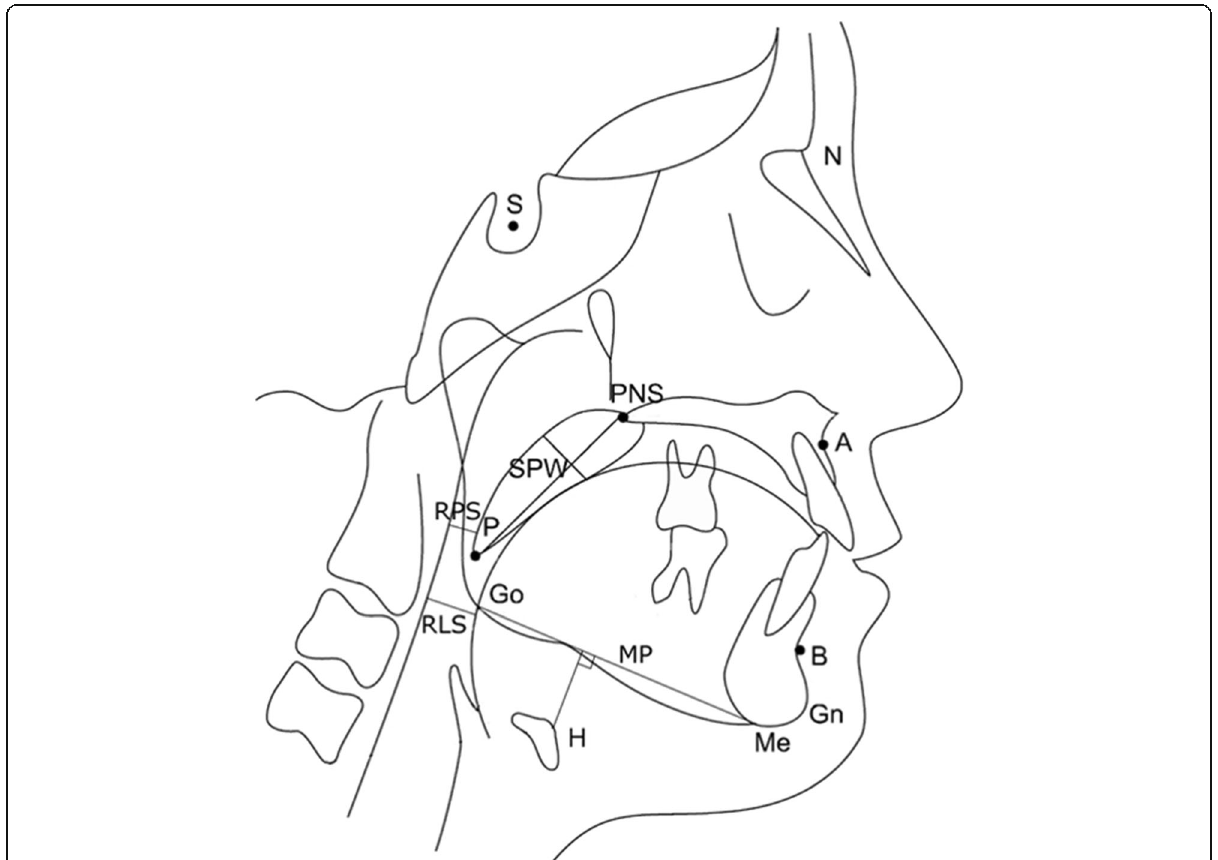
Fig. 1 Linear and angular measurements for bony and soft tissue framework in lateral cephalometry. S (sella), midpoint of the fossa hypophysealis; N (nasion), anterior point at the frontonasal suture; A, the deepest anterior point in the concavity of the anterior maxilla; B, the deepest anterior point in the concavity of the anterior mandible; PNS (posterior nasal spine), the most posterior point on the nasal spine; Go (gonion), a mid-point at the gonial angle located by bisecting the posterior and inferior borders of the mandible; Gn (gnathion), the most anteroinferior point on the chin bone; Me (menton), the most inferior point on the chin bone; P, the inferior tip of the soft palate; H, the most anterosuperior point on the hyoid bone; MP (mandibular plane), a tangent line from Me to the inferior mandibular